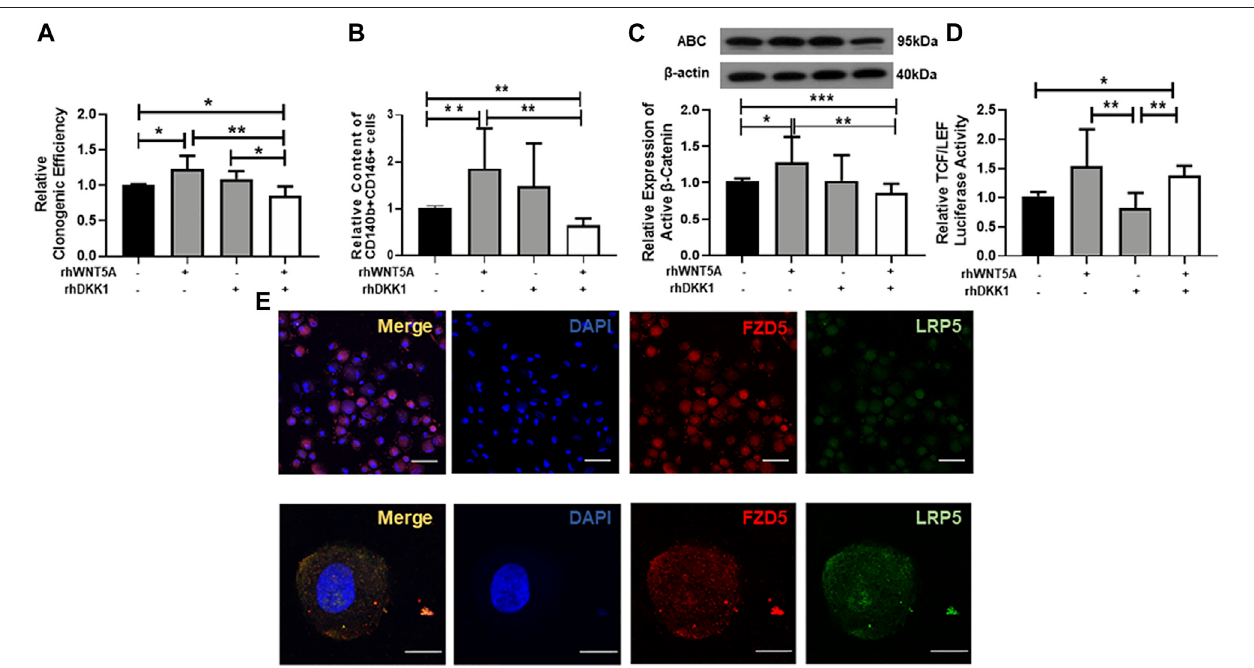
FIGURE 5 | Effect of neutralizing LRP5 on eMSC activities. (A) Relative clonogenic ef fi ciency of eMSC colonies in control (black bars), GM containing 0.01 μ g/ml rhWNT5A or 0.1 μ g/ml rhDKK1 protein (gray bars) and combination of 0.01 μ g/ml rhWNT5A with 0.1 μ g/ml rhDKK1 protein (n = 5). (B) Relative proportion of CD140b + CD146 + cells (n = 5). (C) Relative expression of active β -catenin in eMSC in control (black bars), GM containing 0.01 μ g/ml rhWNT5A or 0.1 μ g/ml rhDKK1 protein (gray bars) and combination of 0.01 μ g/ml rhWNT5A with 0.1 μ g/ml rhDKK1 protein (n = 7, normalized to β -actin). (D) The TCF/LEF luciferase signal of eMSC after treatment with growth medium containing 0.1 μ g/ml rhDKK1 protein with or without 0.01 μ g/ml rhWNT5A (gray bars) and 0.01 μ g/ml rhWNT5A or rhDKK1 (white bars) (n = 7). (E) Coexpression of FZD5 (red) and LRP5 (green) on eMSC. Results are presented as mean ± SD, * p < 0.05, ** p < 0.01. Scale bar: 50 µm (lower magni fi cation) and 10 µm (higher magni fi cation). Abbreviations: ABC, active β -catenin; DKK-1, Dickkopf-1; eMSC, endometrial mesenchymal stem-like cells; FZD, frizzled; GM, growth medium; LRP, low-density lipoprotein-related